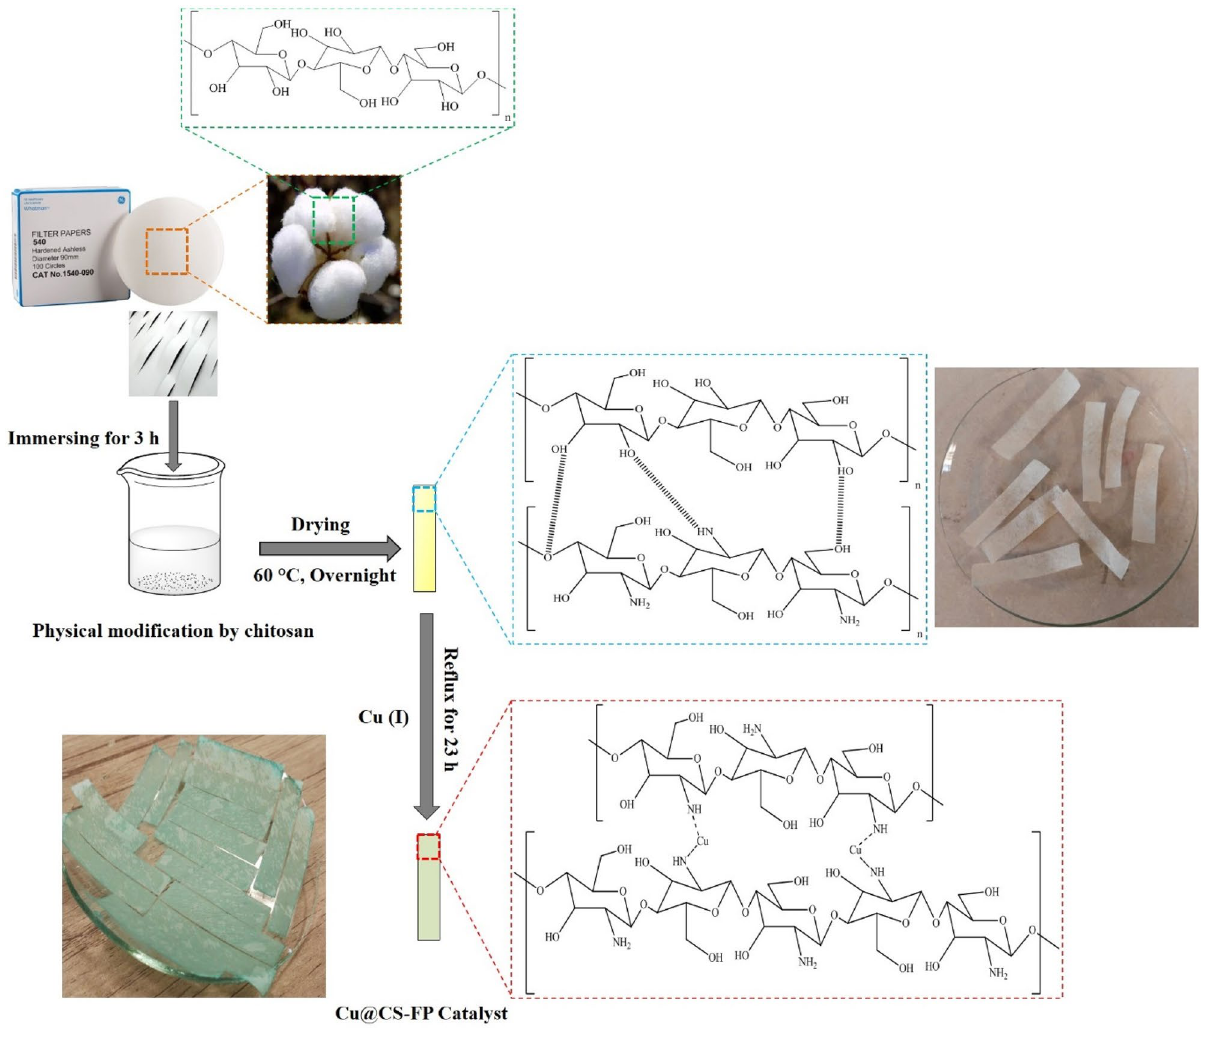
Figure 1. The preparation steps of Cu@CS-FP dip